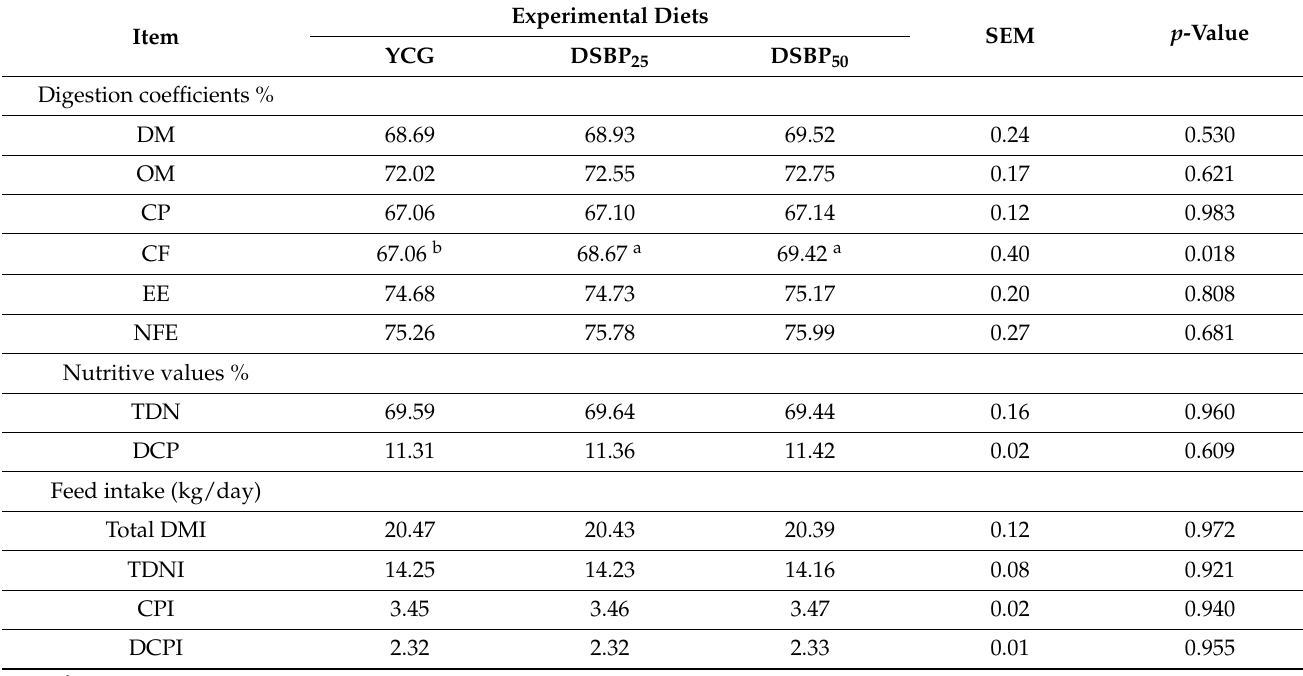
Table 5. Nutrient digestion and feeding values of experimental diets.